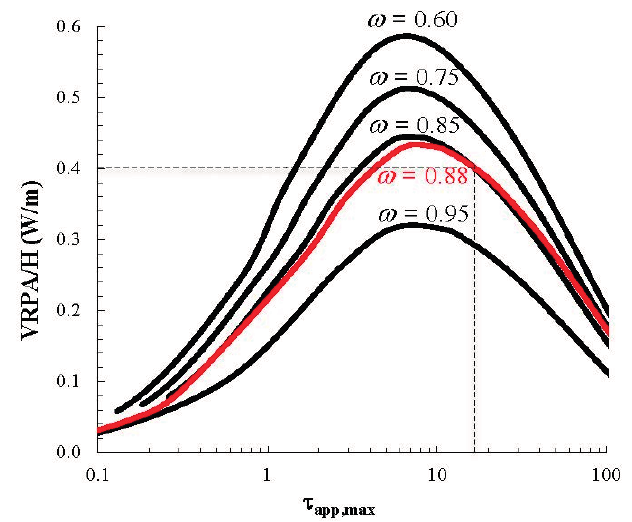
Figure 6. Effect of the maximum optical thickness on the VRPA per unit of length of a CPC solar reactor. Adapted from Colina-Marquez et al . [37].